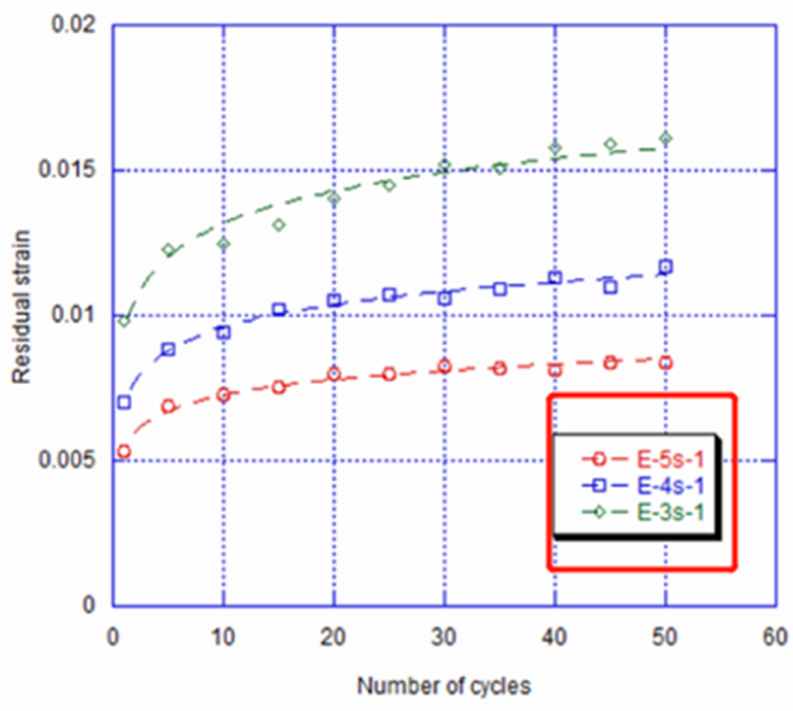
Figure 6. Evolution of residual strain at zero stress as a function of number of cycles for cyclic deformed specimen with 7.1% strain after different imposed strain rates of 10 − 5 s − 1 , 10 − 4 s − 1 and 10 − 3 s − 1 (represents the fitting